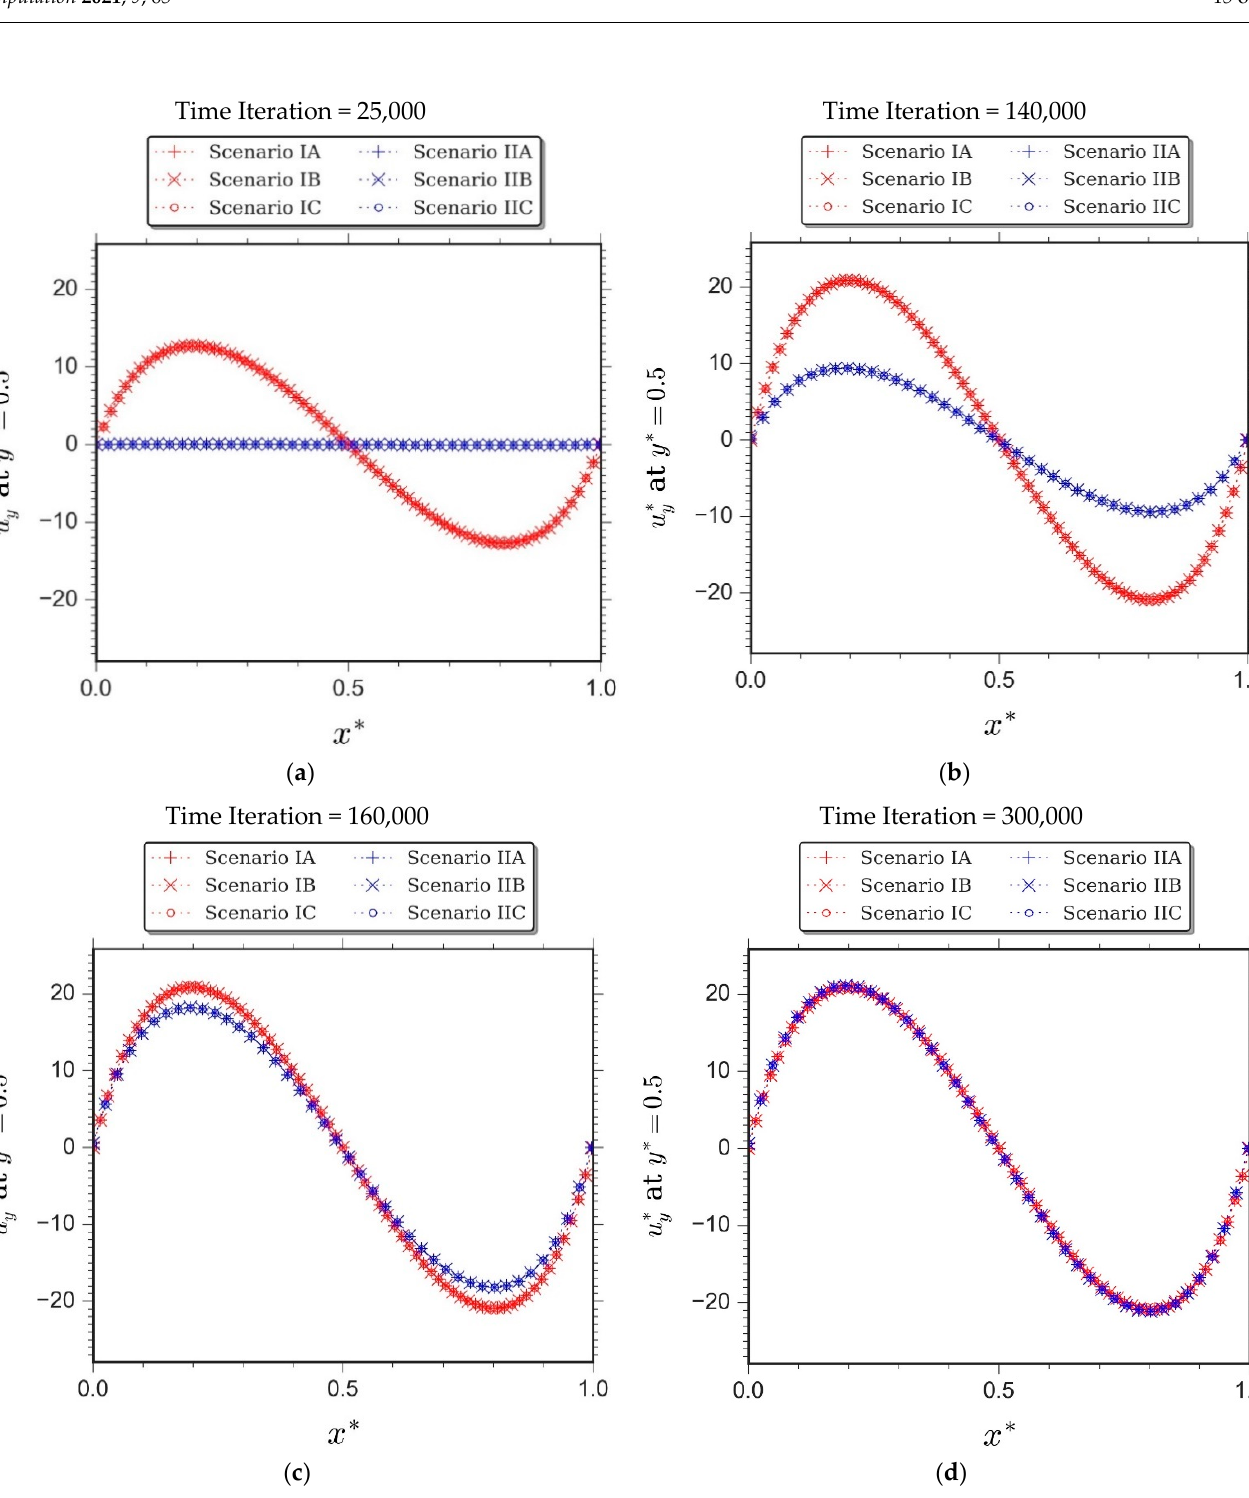
Figure 9. Profiles of dimensionless vertical velocity at the horizontal mid-plane of the cavity upon different simulation periods of Rayleigh-Bènard convection for aspect ratio = 1, Ra = 10 4 , Pr = 0.71, τ υ = 0.6, and Ma = 0.1, demonstrating conditions at the following time iterations: ( a ) 25,000; ( b ) 140,000; ( c ) 160,000; and ( d ) 300,000.